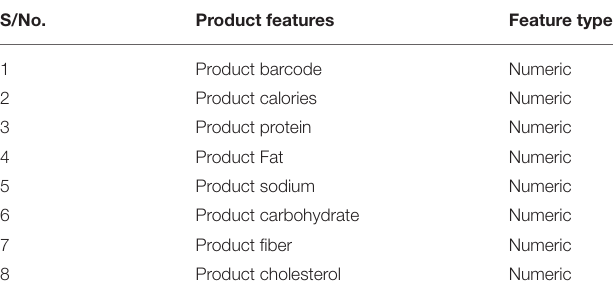
TABLE 1 | Number of features in the product. S/No.